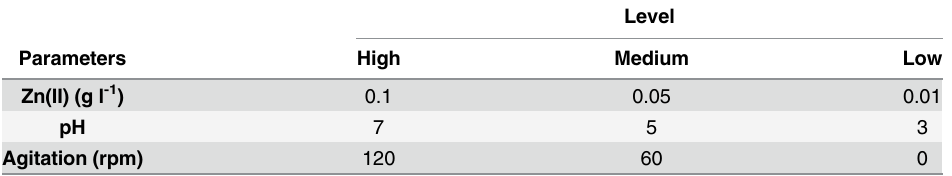
Table 1. Different Levels (Low, Medium and High) of the Parameters Applied to Optimize EPS